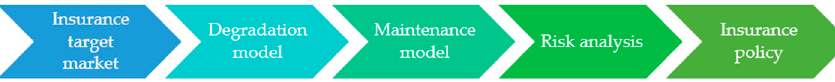
Figure 2. Research methodology for the definition of an insurance policy for ETICS.